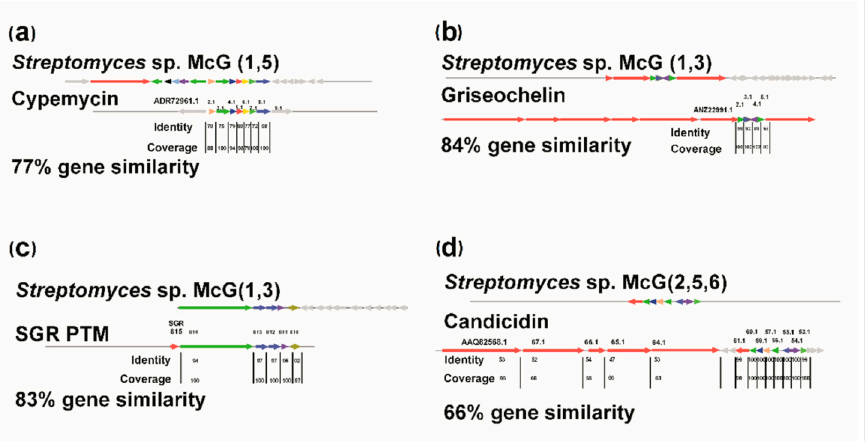
Figure 2. Biosynthetic cluster similarities between Streptomyces McG isolates and known antibiotic genes for ( a ) cypemycin, ( b ) griseochelin, ( c ) SGR PTM, and ( d ) candicidin.